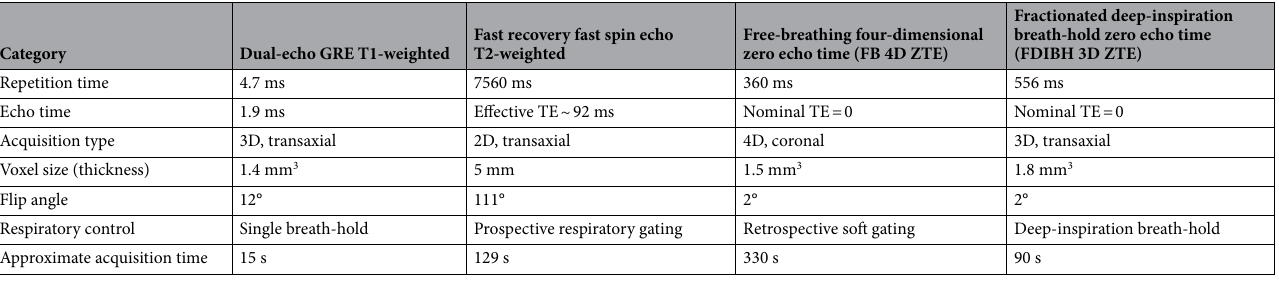
Table 1. Imaging parameters for pulmonary MRI